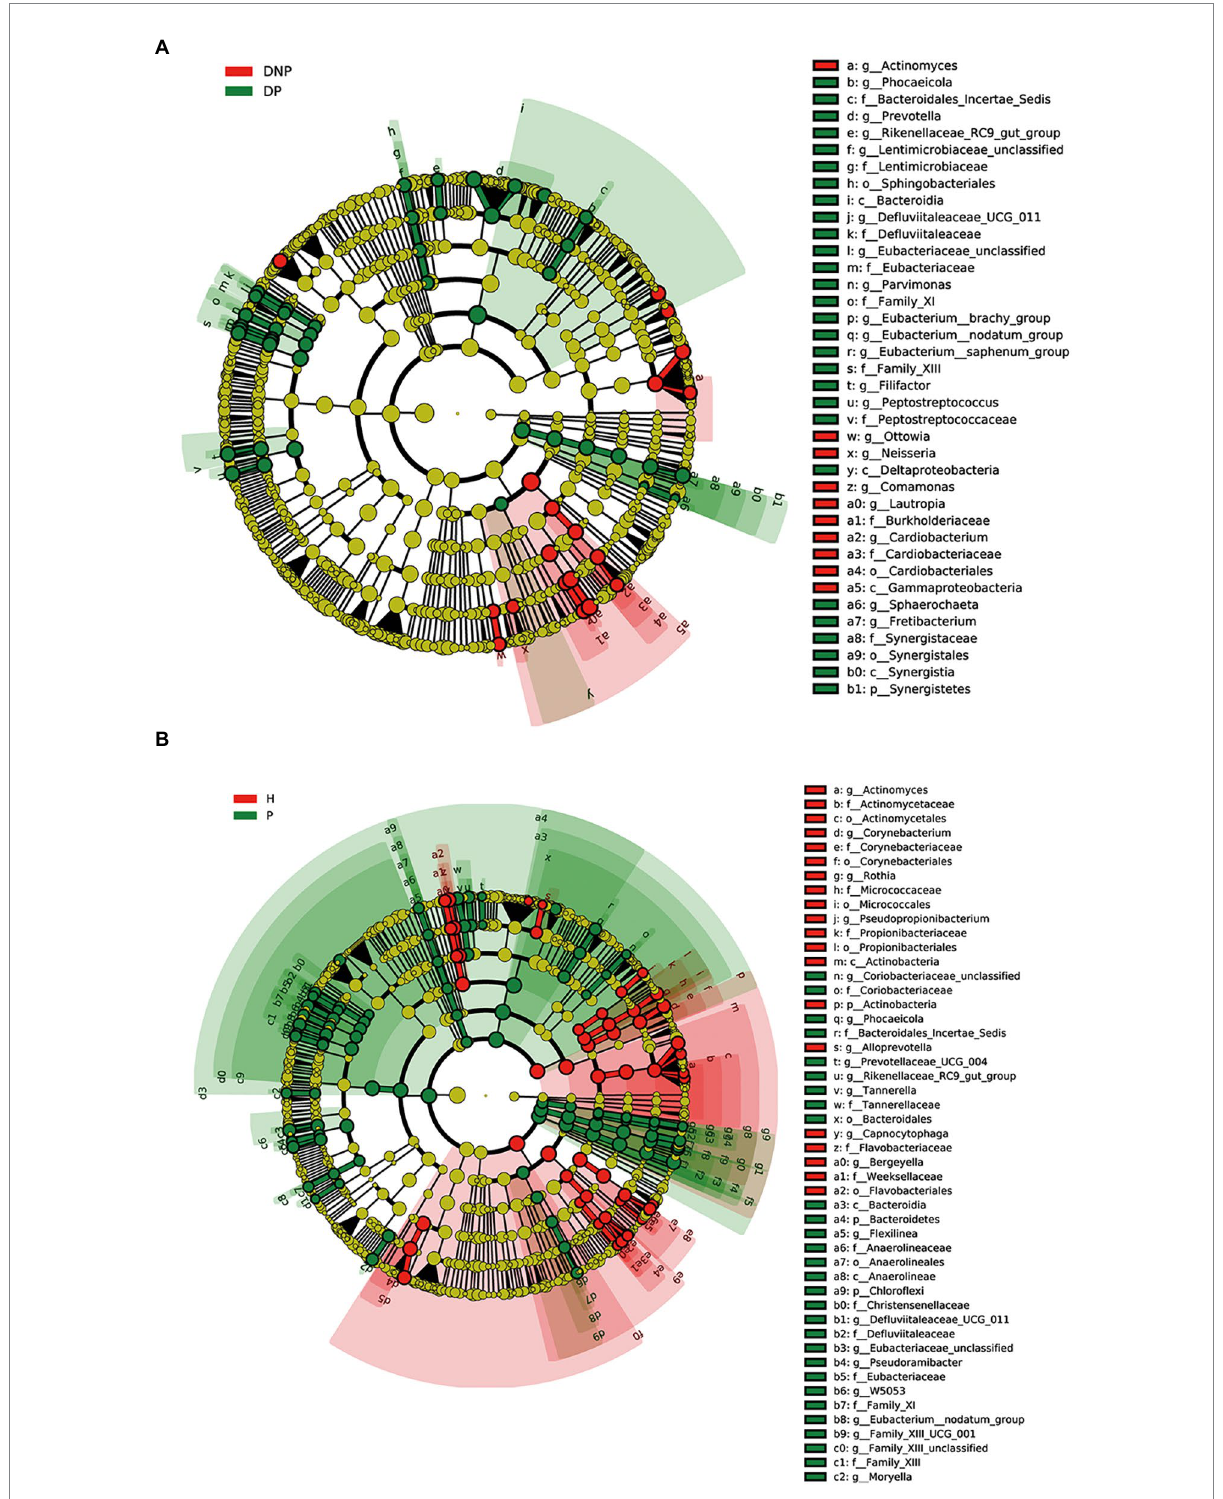
FIGURE 4 Differences in subgingival micro-organism composition among DP, DNP, P, and H groups. (A) Differential subgingival microbial taxa between DP and DNP shown as cladogram by LEfSe analysis; (B) Differential subgingival microbial taxa between P and H shown as cladogram by LEfSe analysis. The phylum, class, order, family, and genus levels are listed in order from inside to outside of the cladogram and the labels for levels of class, order, family, and genus are abbreviated by a single letter. The green and red circles represent the bacteria enriched in the group of H or DNP, P or DP, respectively, whereas the yellow circles represent the taxa with no significant differences between